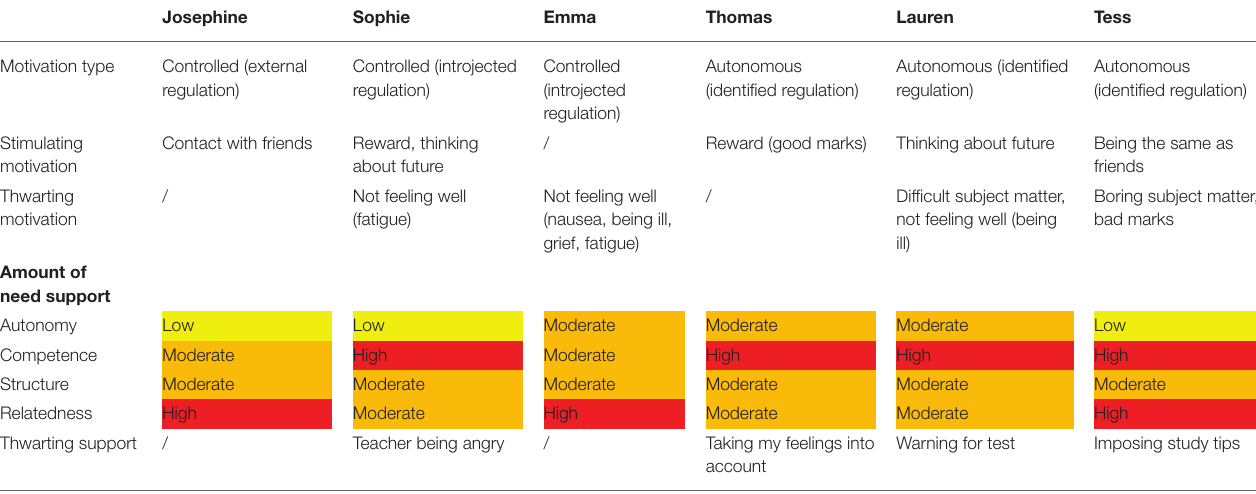
TABLE 3 | Schematic overview of findings concerning motivation and need